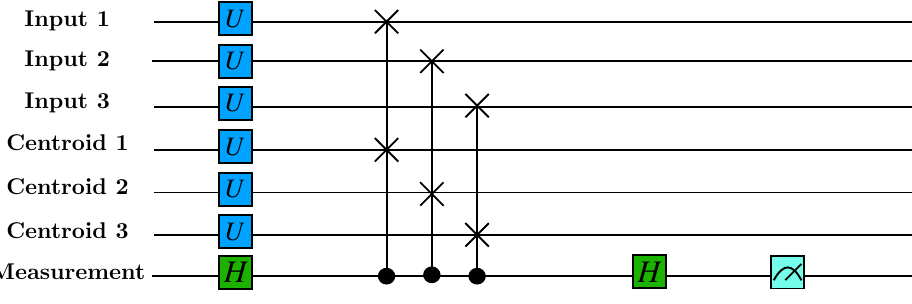
Figure 7. Diagram of the Q-means quantum circuit. The feature vector and centroid is encoded through U 3 gates, while a SwapTest is used to provide a measure of their